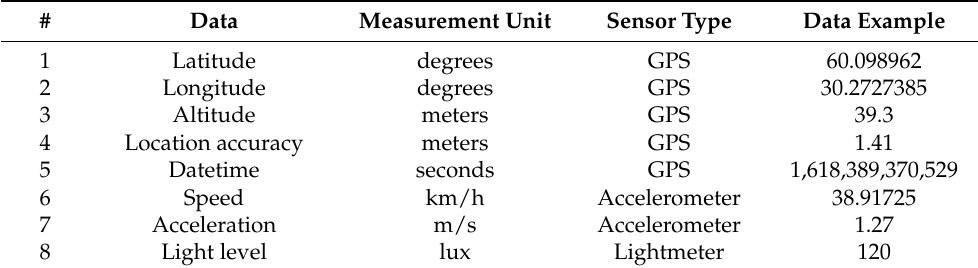
Table 2. Sensors data